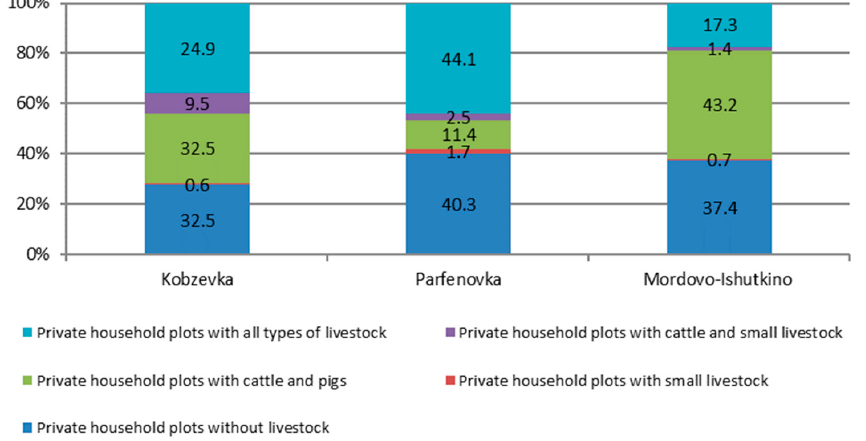
Figure 4. Comparison of private household plots by livestock availability in 2014–2018.